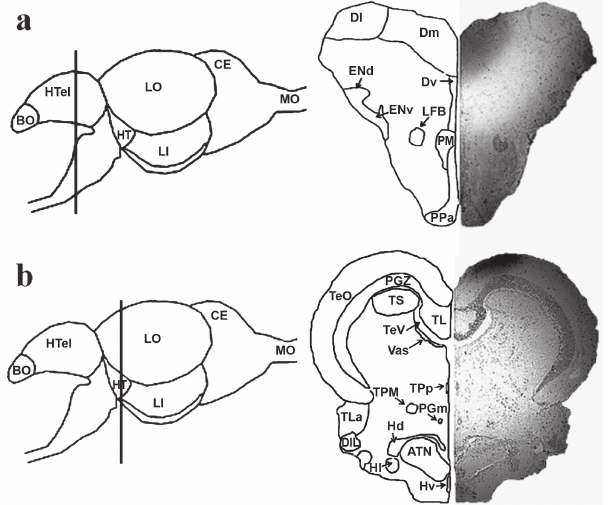
Fig. 1. Cross-section of preoptic area (AP) and posterior diencephalic region (PDR) of Paracheirodon axelrodi showing its different neuronal nuclei. a. Panoramic view of AP showing different neuronal nuclei. b. Panoramic view of PDR, including HT neuronal nuclei. Technique: high resolution optical microscopy (HROM) Bar 100 μm.